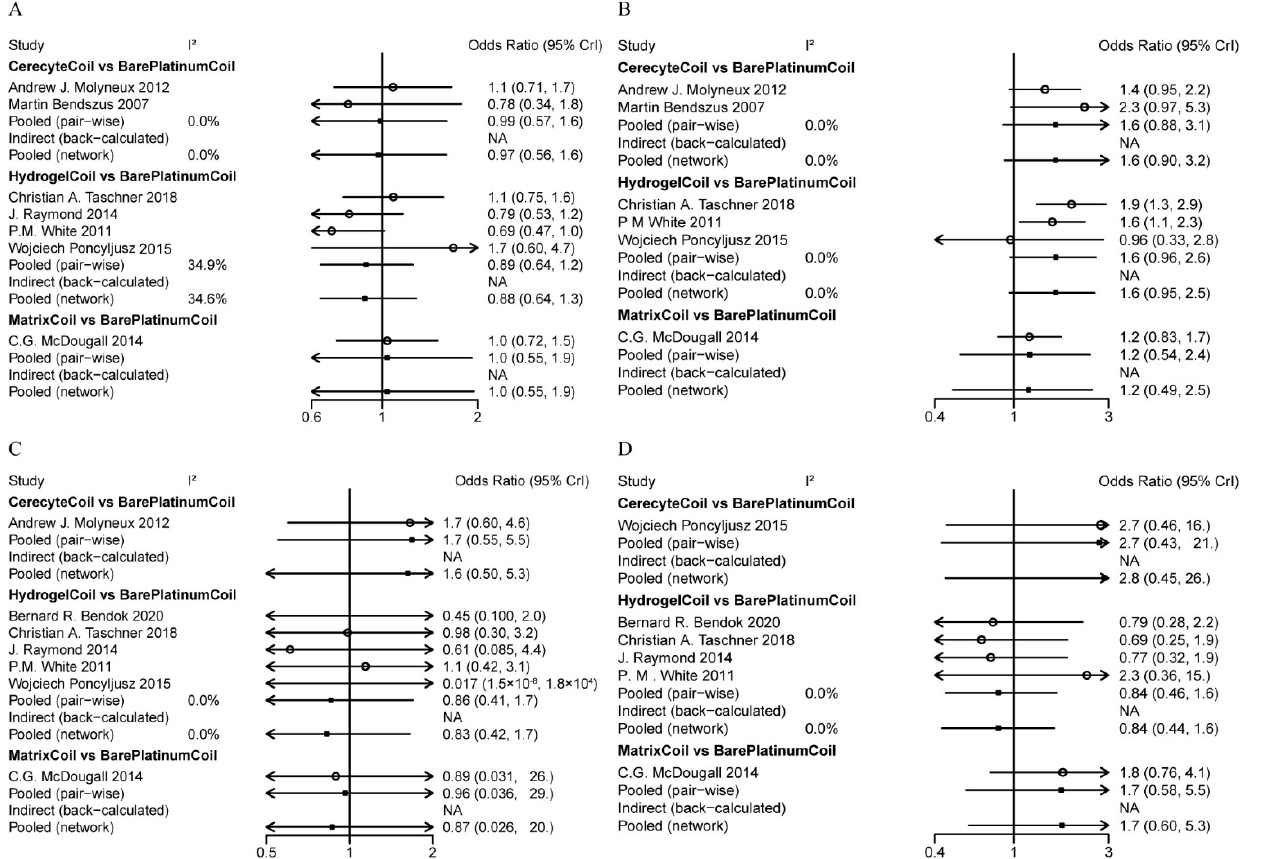
Figure 5. Forest plots for the heterogeneity of efficacy and safety indicators. ( A ) Percentage of postoperative patients with modified Raymond scale grade I; ( B ) Percentage of patients with modified Raymond scale grade I at follow-up; ( C ) Rates of intraoperative aneurysm rupture or re-rupture; ( D ) Mortality rate.